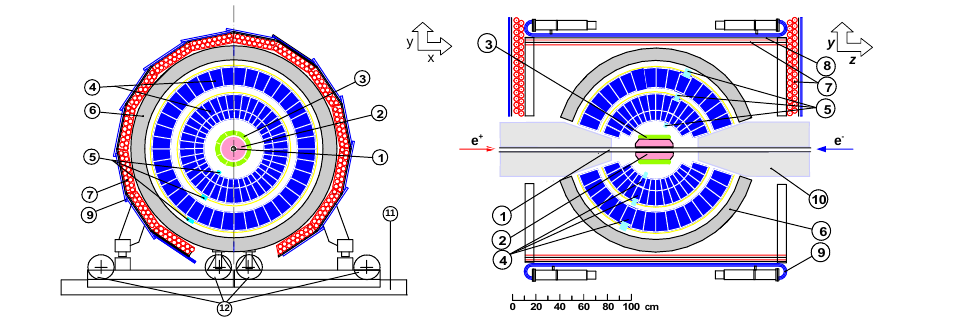
Figure 1. The SND scheme: 1 — vacuum pipe, 2 — tracking system (TS), 3 — threshold Cherenkov counter, 4–5 — electromagnetic calorimeter (NaI (Tl)) (EMC), 6 — iron absorber, 7–9 — muon detec- tor, 10 — focusing solenoids, 11 – rails, 12 – wheels.